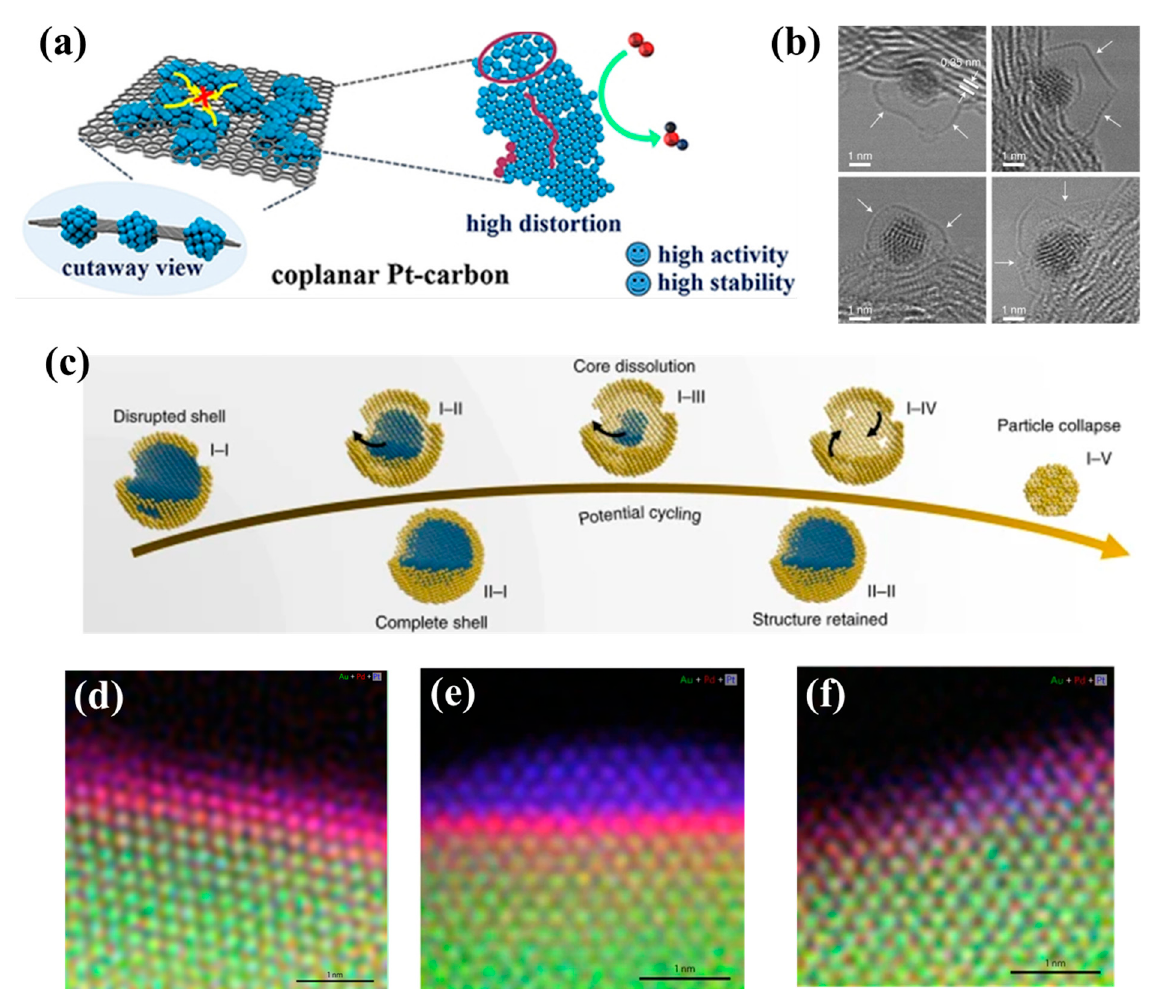
Figure 7. ( a ) Schematic illustration of two-dimensional coplanar Pt–carbon nanomeshes. Reprinted with permission from Ref. [67]. Copyright 2021, Angewandte Chemie International Edition. ( b ) Bright- fi eld STEM images highlight the enclosure of ultra- fi ne nanoparticle by graphene nanopock- ets (indicated by white arrows). Reprinted with permission from Ref. [18]. Copyright 2022, Nature